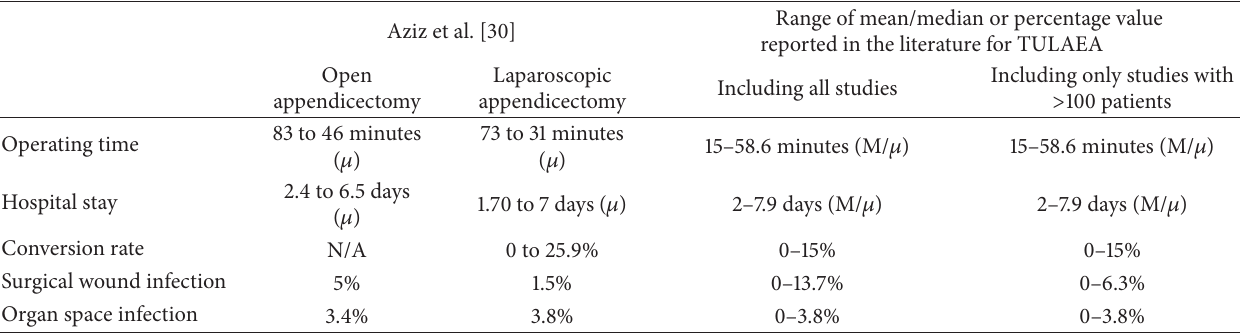
Table 4: Comparison of outcomes with meta-analysis data of open versus laparoscopic appendicectomy, data published by Aziz et al. [30]. Range of mean/median or percentage Aziz et al. [30]